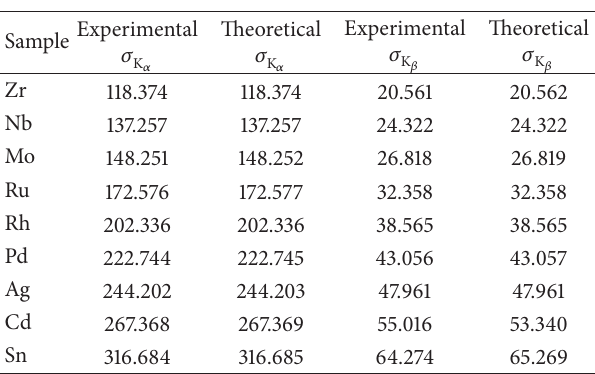
Table 2: The experimental 𝜎